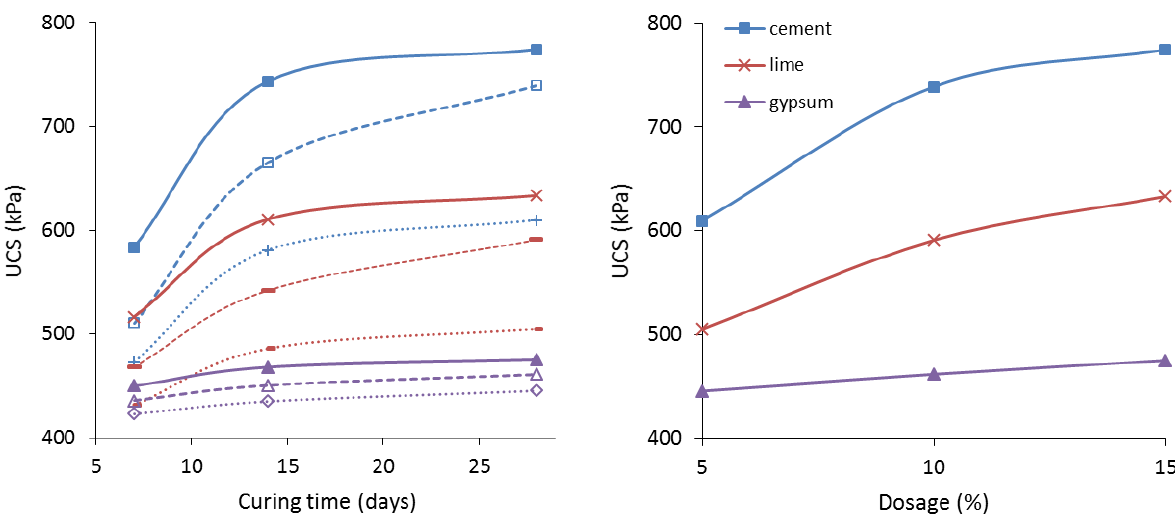
Figure 3. Left: variation of unconfined compressive strength (UCS) with curing time for specimens of Chaghakhor peat stabilised with 400 kg m -3 of sand and 10 % by weight of tyre chips, with different percentages of the three pozzolanic additives. For key to symbols, see Figure 4 (below). Right: variation of UCS with dosage (%) of each of the three pozzolanic additives (gypsum, lime, ordinary Portland cement) for the same specimens after a curing time of 28 days.